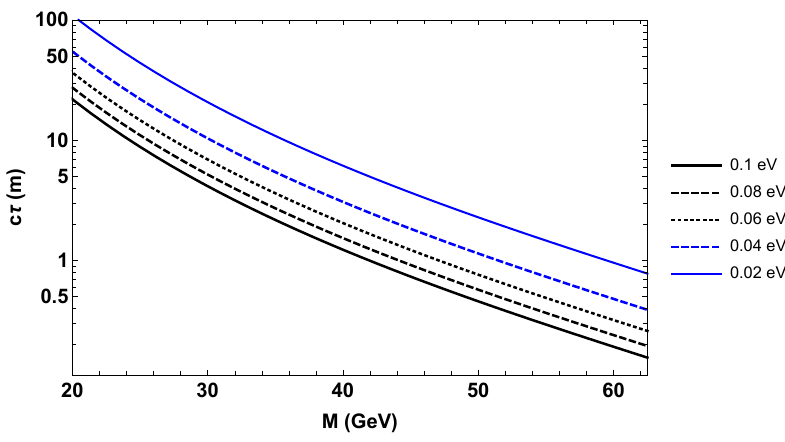
Figure 1 . Right-handed neutrino mean decay length (m) as a function of right-handed neutrino Majorana mass (GeV) for di(cid:11)erent (cid:12)xed values of physical neutrino